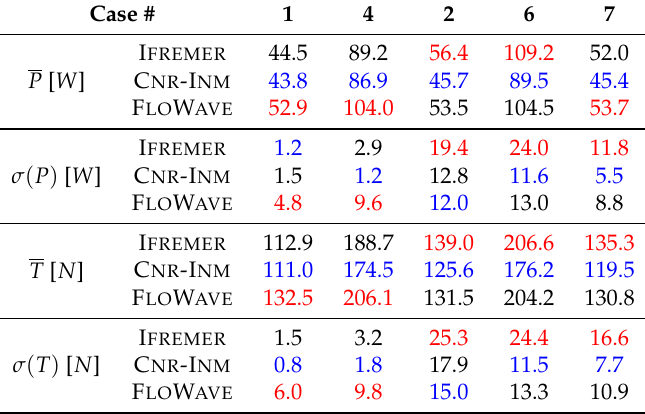
Table 5. Average and standard-deviation of the row power and thrust measured on the turbine for current-only cases ( 1 and 4 ) and for combined wave and current cases ( 2 , 6 and 7 ). For each case and each tank, TSR is chosen to correspond to the highest power value, that is, TSR highlighted in colour correspond to the highest (red) or lowest (blue) parameter values, for each tested case. Case #